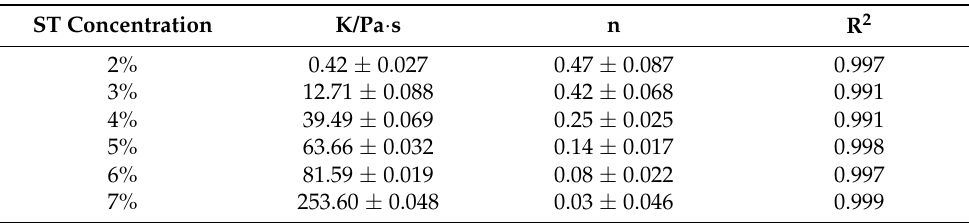
Figure 6. Changes in the apparent viscosity of stigmasterol organogels with different stigmasterol concentrations (2–7%) and shear rates ranging from 0.01 s − 1 to 100 s − 1 . Table 1. Values of power-law parameters (K, n) of the stigmasterol organogels at different stigmasterol concentrations in the range of 0.01–100 s − 1 .